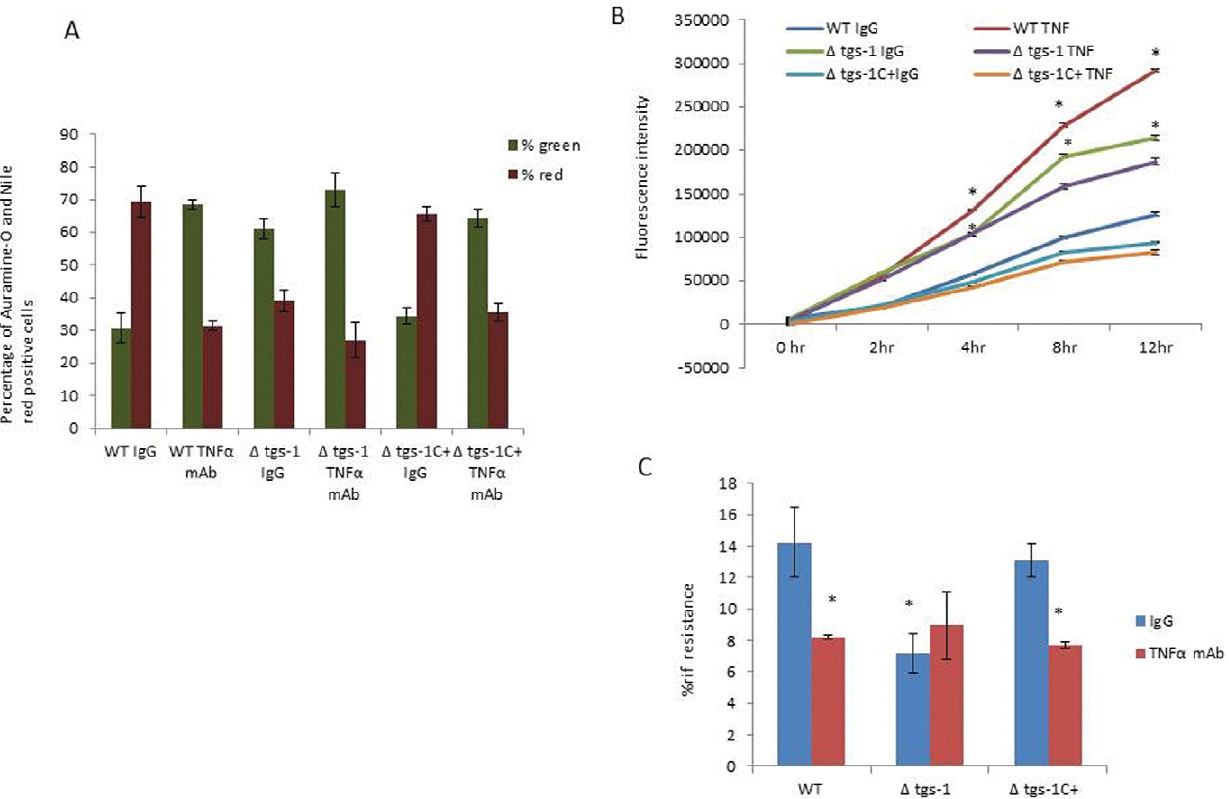
Figure 7. tgs1 deletion compromised the ability of the Mtb to go into a dormant state. ( A ) Auramine-O and Nile red staining of WT and D - tgs1 mutant and D -tgs1 complemented strain ( D -tgs1C + ) population in in vitro granuloma. ( B ) Alamar Blue readouts at different time intervals when WT and D -tgs1 mutant and D -tgs1 complemented strain from granulomas treated with anti-TNF- a antibody or IgG, were incubated with Alamar blue dye. (data of one representative data set has been displayed.) ( C ) D -tgs1 mutant from granulomas treated with IgG or anti-TNF- a antibody had a lower antibiotic resistance as compared to WT Mtb cells from IgG treated granulomas. Data are presented as mean + / 2 SEM from 3 experiments. P values were calculated using students t test. *p , 0.05.